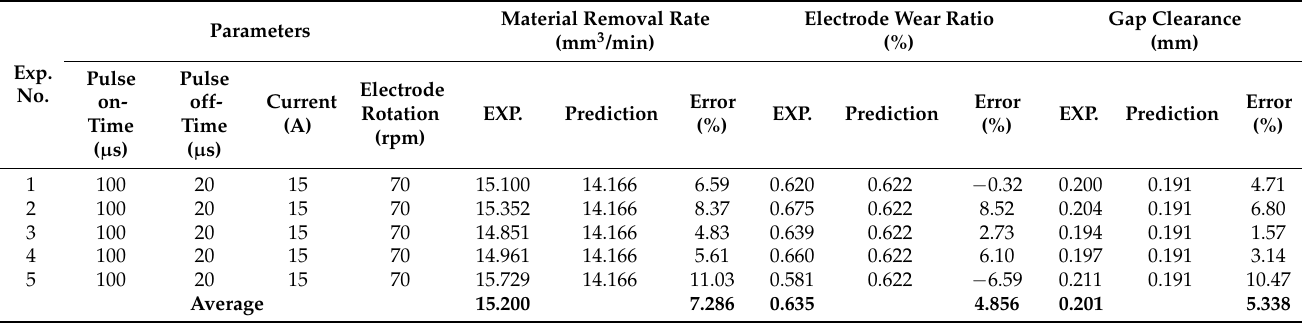
Table 11. The response surface methodology predicted and experimental results under the optimal machining condition of EDM with side